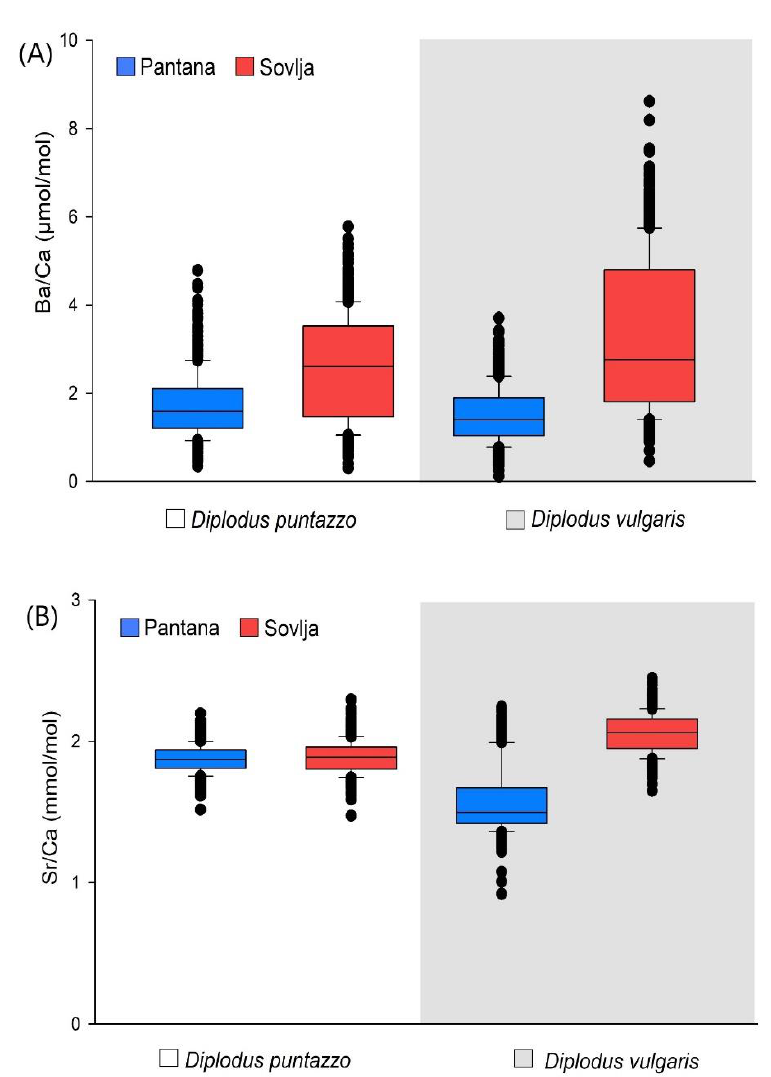
Figure 3. Box plots of median ( ± standard deviation) Ba/Ca ( A ) and Sr/Ca ( B ) otolith ratios (mmol/mol) of Diplodus puntazzo and Diplodus vulgaris collected from the Pantan estuarine site and Sovlja coastal site. Black dots present linear raster of Ba/Ca and Sr/Ca otolith ratios for each site and species.